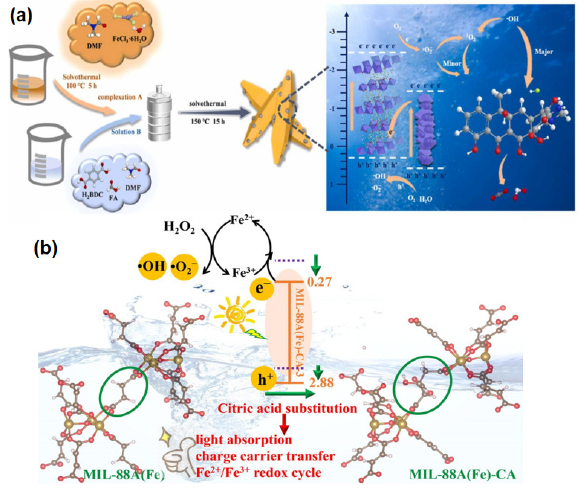
Figure 12. ( a ) Schematic illustration of the reaction mechanism for the TC-HCl removal [75]; ( b ) Schematic illustration of the mechanism in the MIL-88a(Fe)-CA/photo-Fenton process [76]. Table 3. Summary of MILs in photo-Fenton reaction.